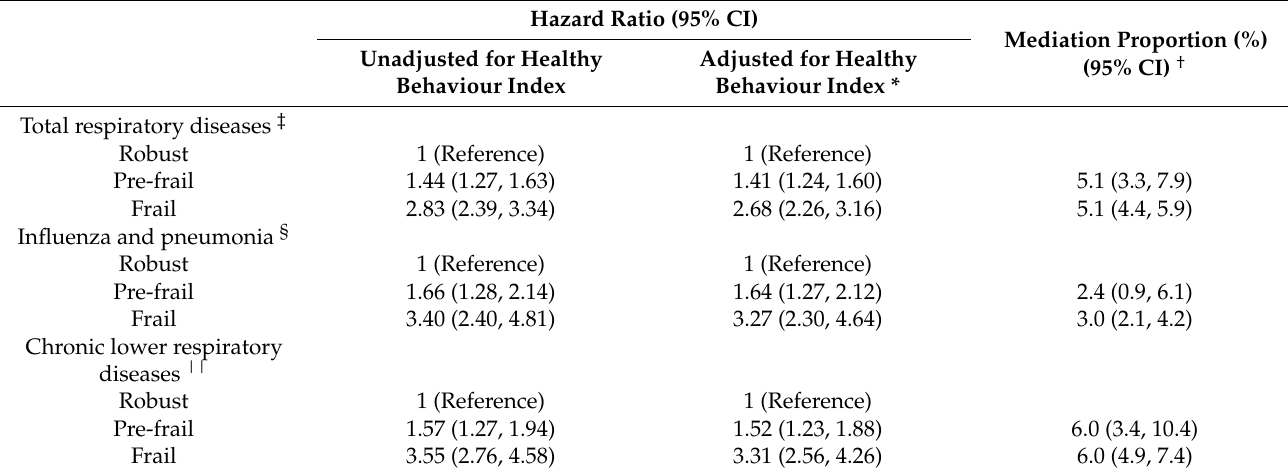
Mediation Proportion (%) (95% CI) † Unadjusted for Healthy